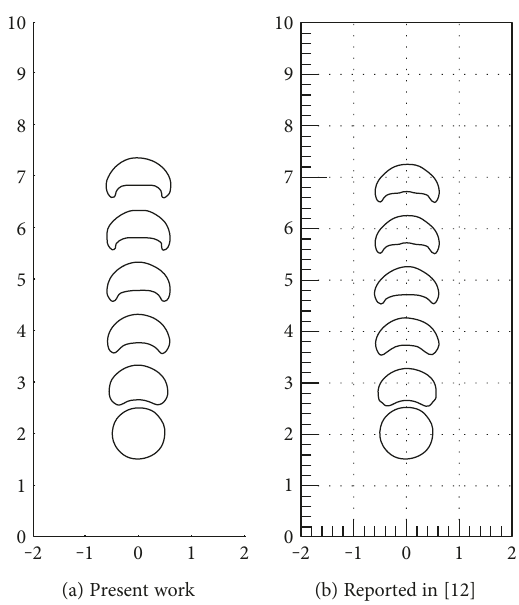
Figure 2: The evolution of a rising bubble with Eo=116 and Re